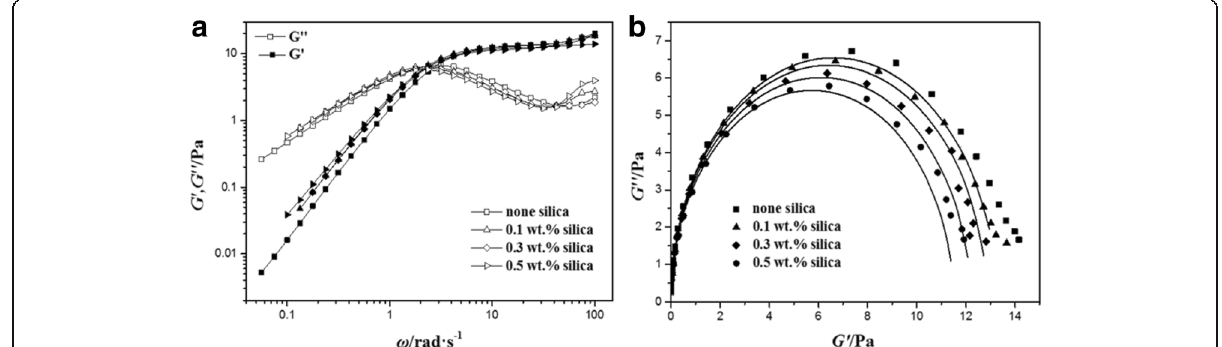
Fig. 3 Variations of G ′ (filled symbols) and G ″ (open symbols) with shear frequency and Cole – Cole plots for NEWMS with different silica concentrations at 25 °